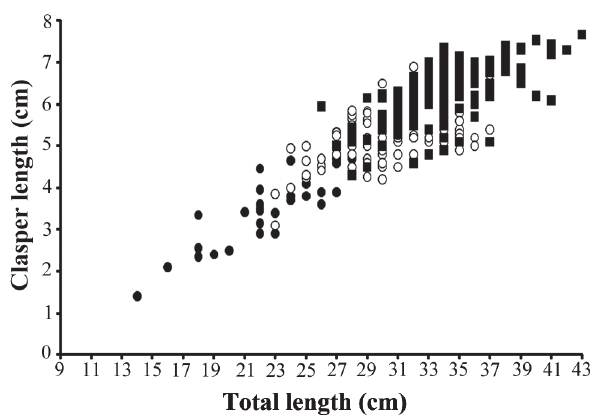
Fig. 7. Relationship between total length and length of the clasper for Discopyge tschudii . Males: immature (  ) n= 34; maturing ( o ) n= 98 and mature (  ) n=